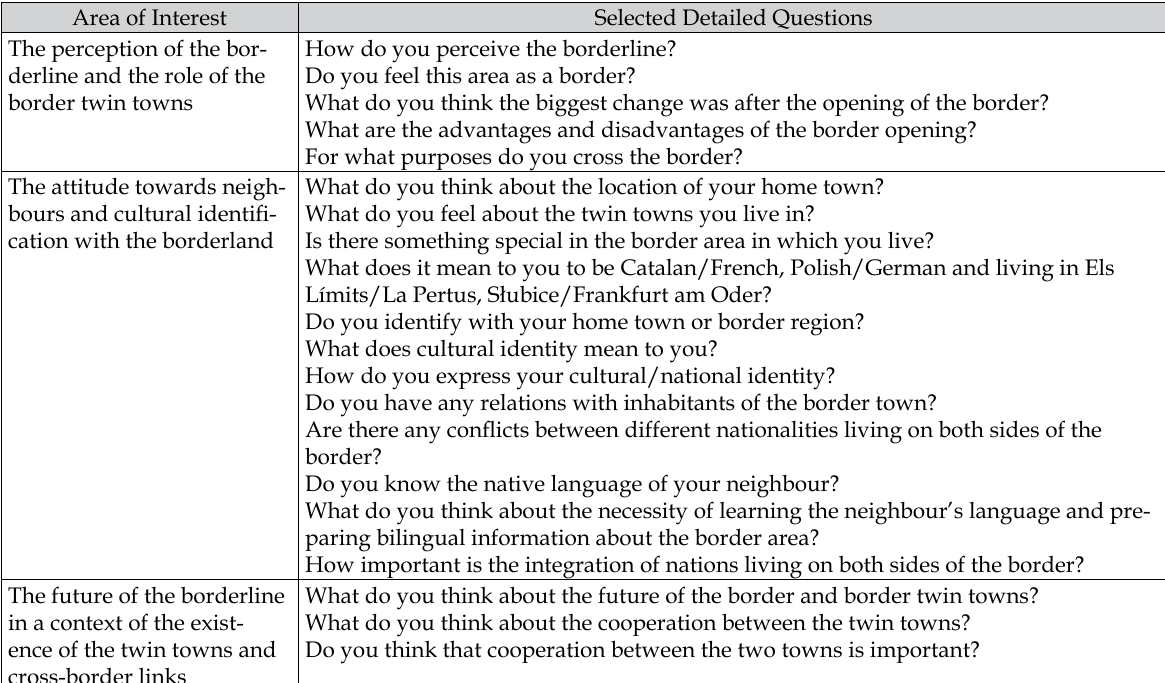
Table 1. Questionnaire’s frame – a range of issues. source: authors’ elaboration.